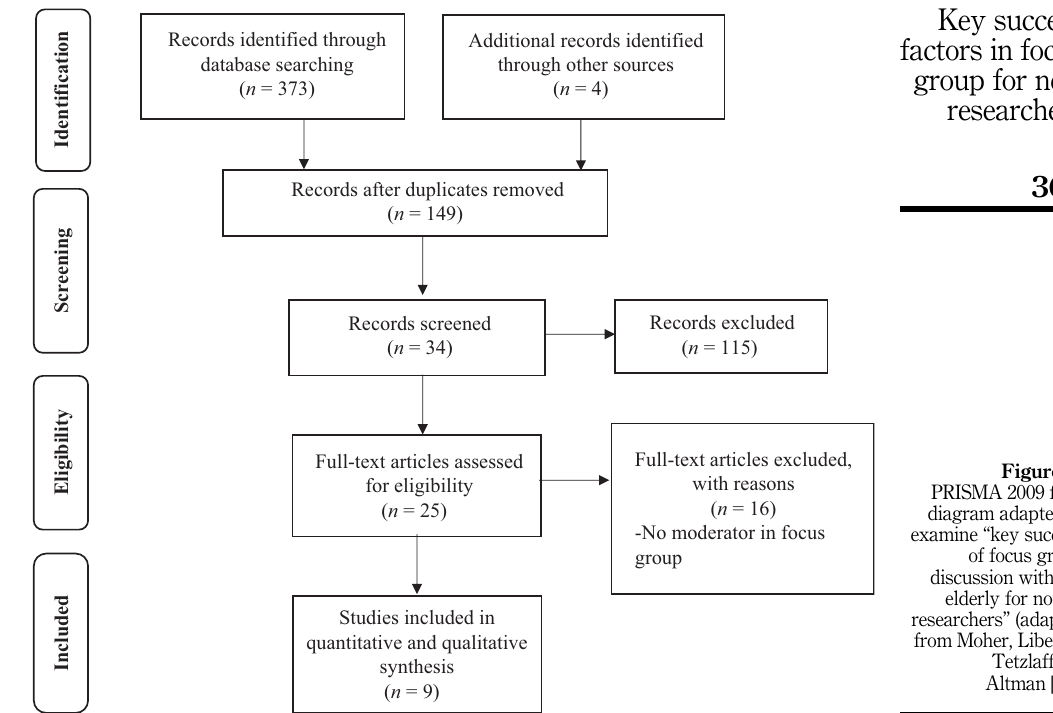
Figure 1. PRISMA 2009